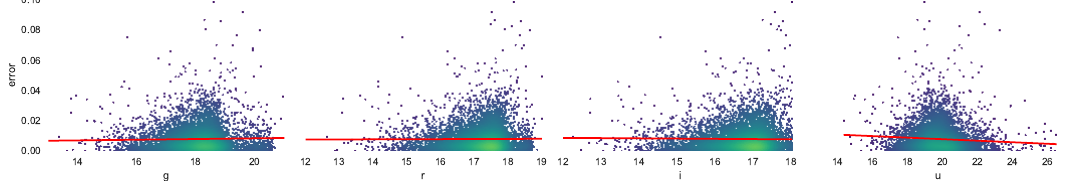
Figure 5. Normalized error when using the Random Forest classifier and different magnitude ranges. Figures 6 and 7 show the absolute and normalized error, respectively, as a function of the color.